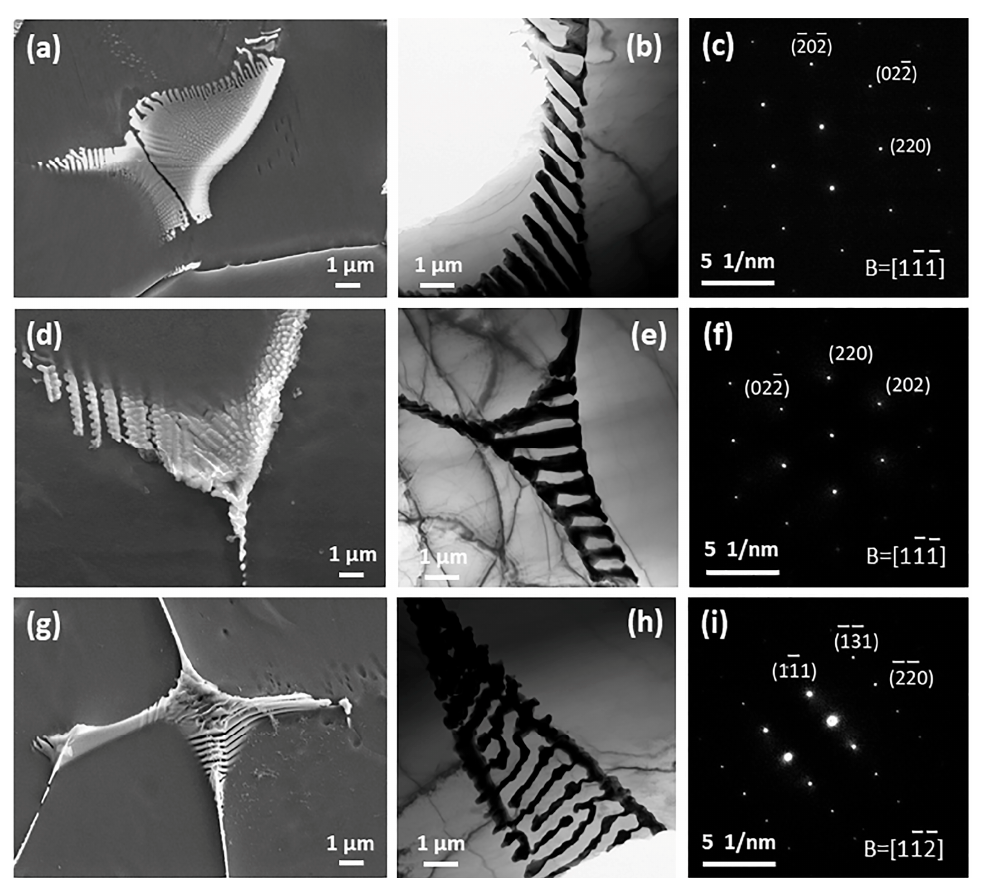
Figure 3. Micrographs of as-cast Alloy2: ( a ) SEM image, ( b , d ) Bright field transmission electron microscope (BF TEM) images and ( c , e ) their corresponding selected area electron diffraction (SAED) patterns.